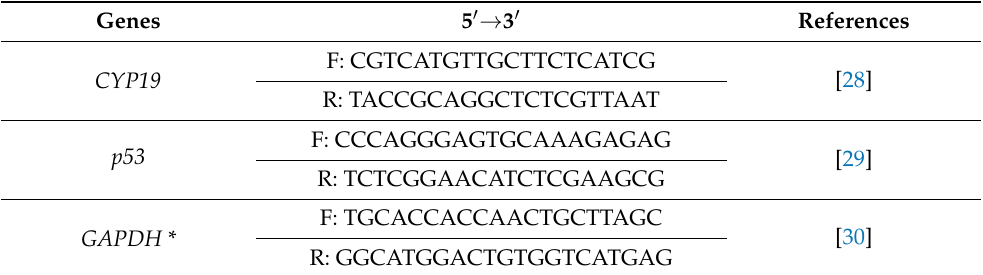
Table 1. Primers’